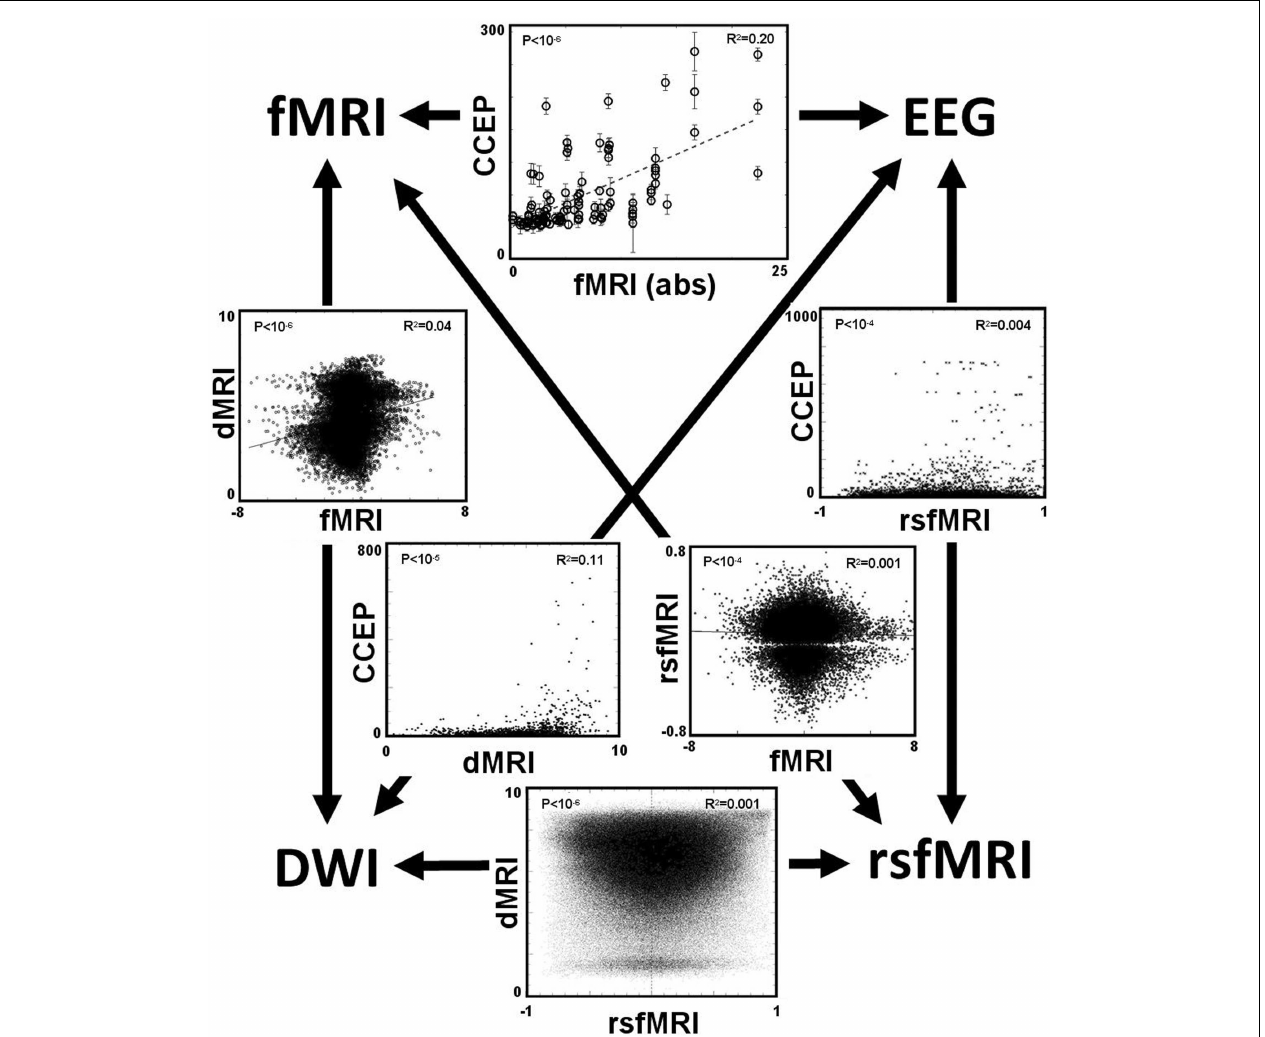
the CCEPs scale in µ V; the units of the rsfMRI are the Pearson correlation coefficient typically ranging from − 1 to 1; the units of fMRI are the statistical t -score (using the absolute value when compared with CCEP); and the units of the dMRI are arbitrary with 0 representing negligible structural connectivity and 10 representing strong structural connectivity.The value of the Pearson correlation coefficient r 2 computed from the data within each plot is printed in the top right corner; its associated p -value is printed in the top left